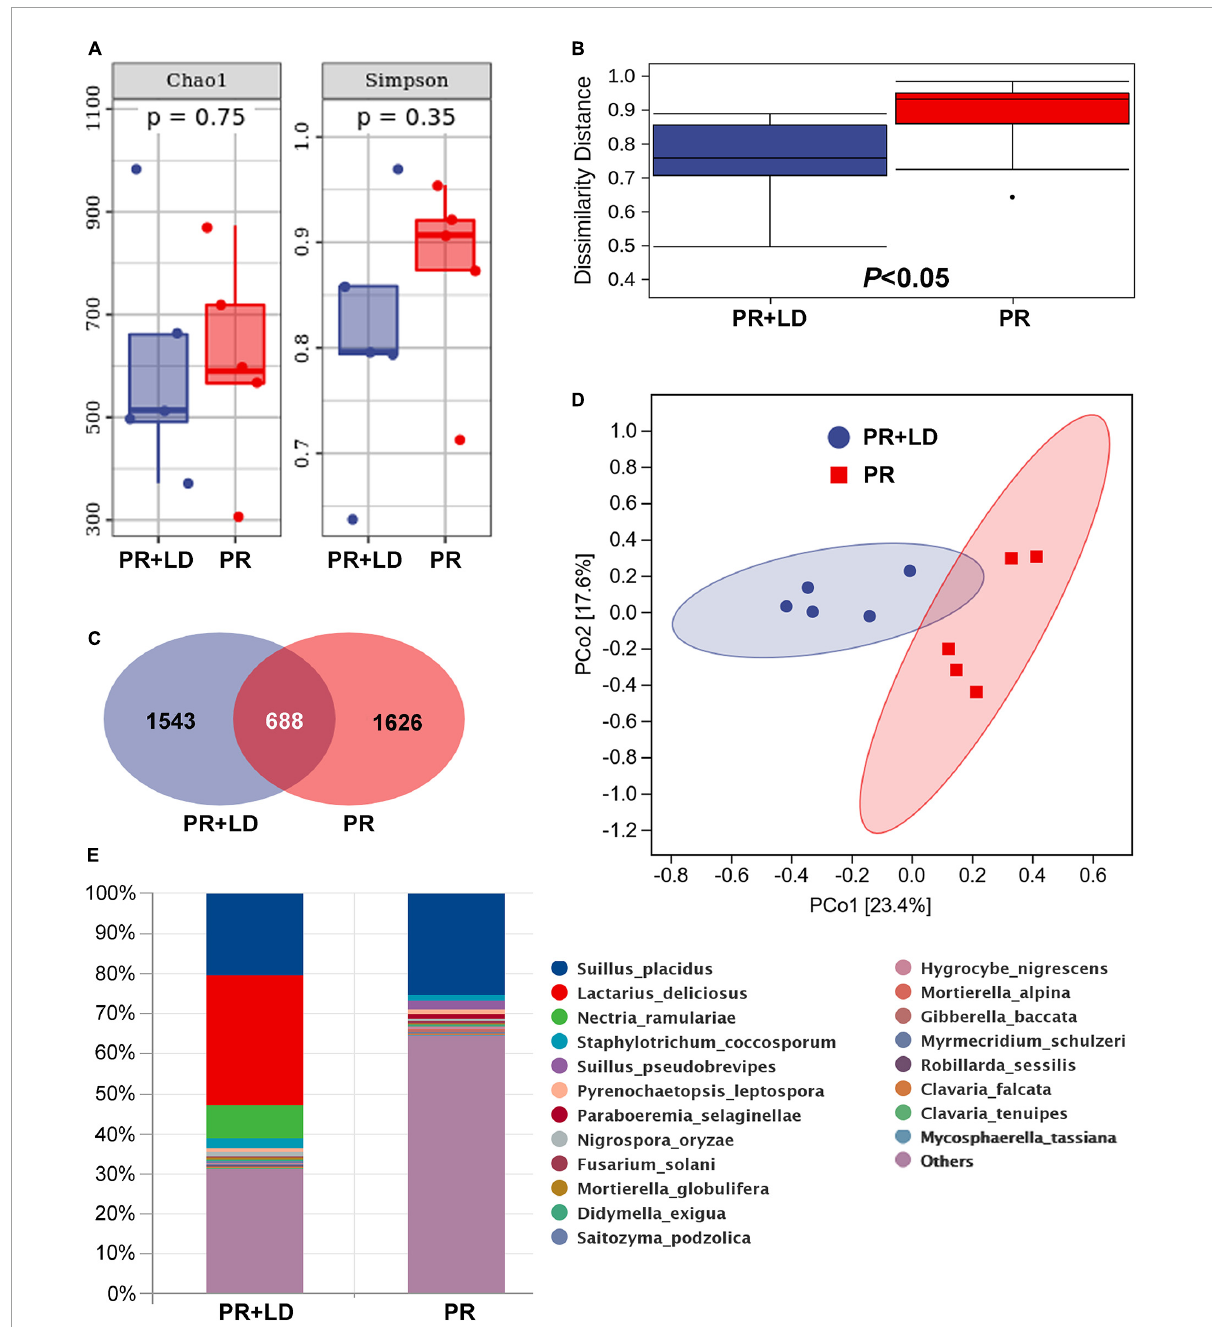
FIGURE2 Mycorrhizosphere and rhizosphere fungal community of Pinus radiata + Lactarius deliciosus (PR + LD) and PR trees in the Xifeng plantation. (A) Chao1 and Simpson indexes. (B) Dissimilarity distance. (C) Venn figure showing shared and unique operational taxonomic units (OTUs) between samples of two trees. (D) Principal Coordinate analysis (PCoA). (E) Relative abundance of fungal composition at the species level.